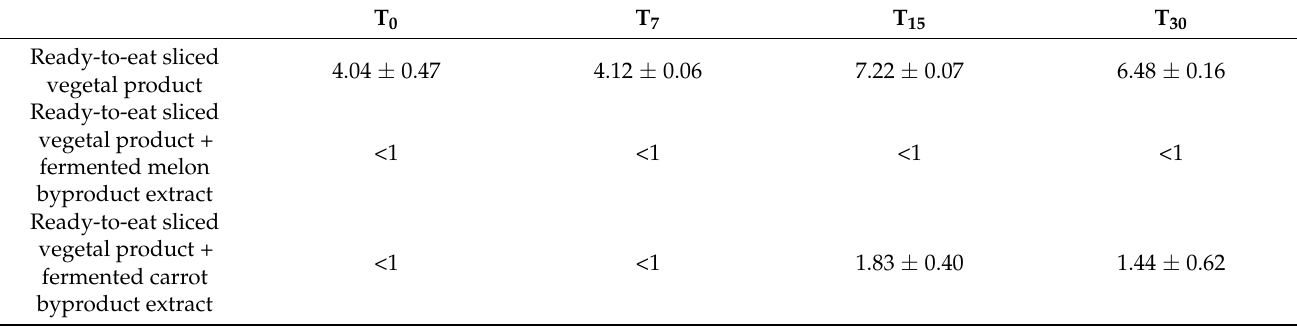
Table 2. Total microbial load ± standard deviation (log 10 CFU/g) in ready-to-eat sliced vegetal product with (1.2%) or without fermented melon and carrot byproduct extracts after its preparation (T 0 ) and after 7 (T 7 ), 15 (T 15 ), and 30 (T 30 ) days of